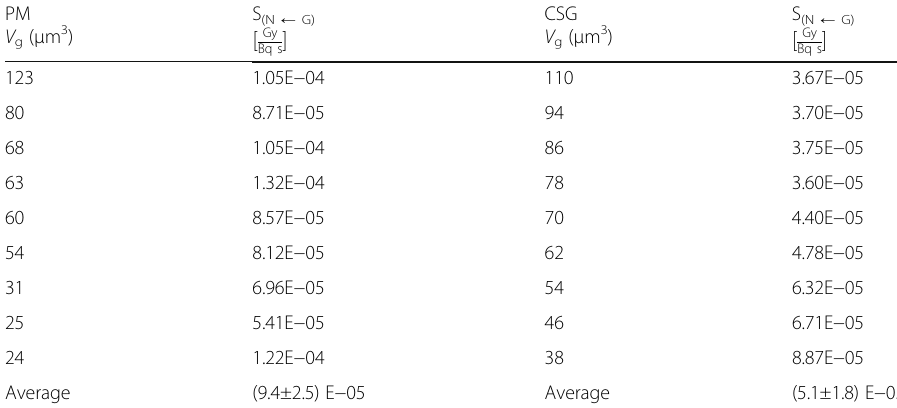
Table 3 Comparison between the doses delivered by Golgi to nucleus for 2 geometrical assumptions: PM models and simplified CSG. The data are listed in increasing order of Golgi volume ( V g ) PM μ m 3 V g (